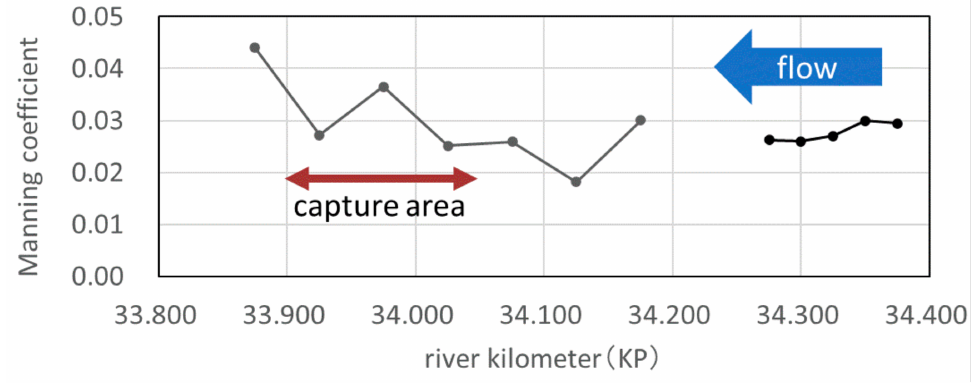
Figure 7. Estimated Manning roughness coefficient along the